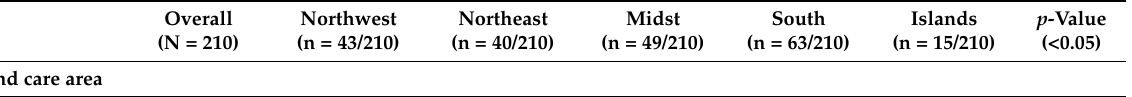
Table 3. Educational wound care area. Each query expects a categorical answer between five different